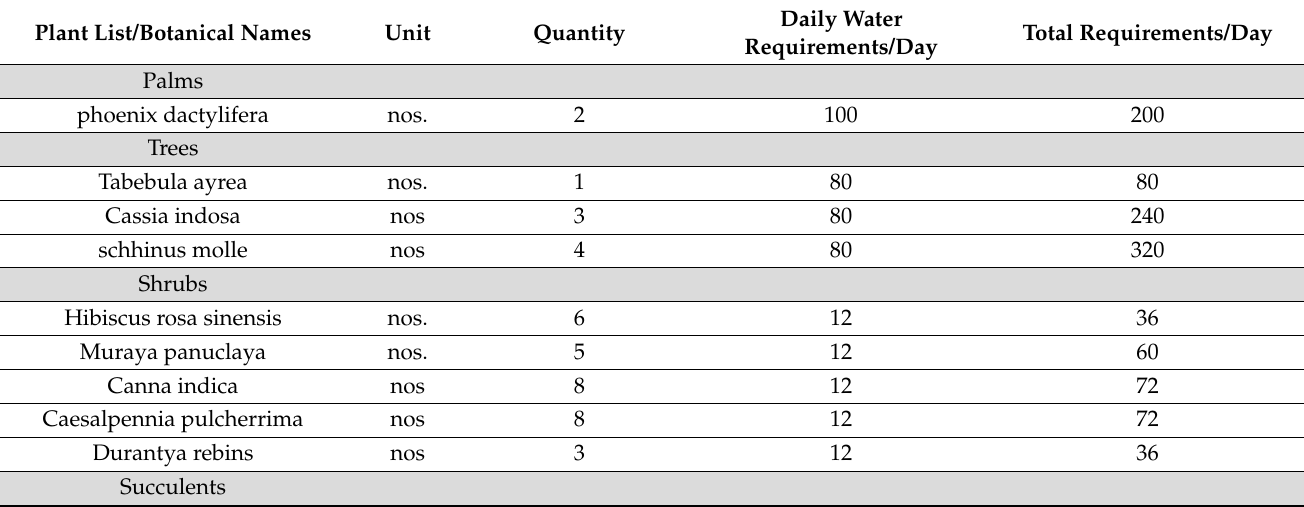
Table A1. Water consumption for each softscape item: previous situation for PARKING 14 landscape